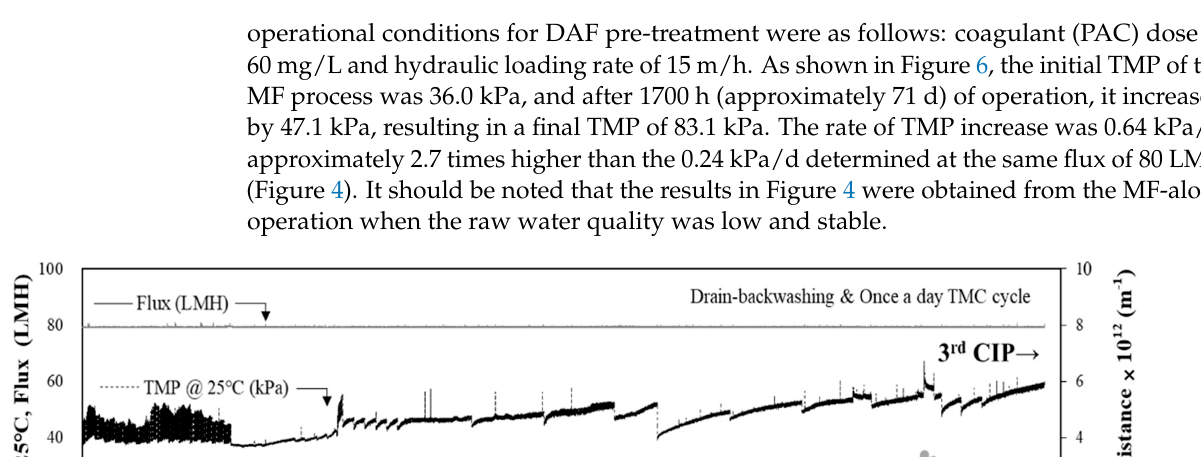
Figure 7. Particle count analysis according to coagulant does and hydraulic loading rate: ( a ) total particle count and ( b ) particle size distribution . 3.4. Performance of DAF-MF Combined Process After Optimising DAF Operating Conditions The MF process in the DAF-MF process was operated for approximately 1400 h (ap- proximately 58 d) at a flux of 80 LMH, and the performance of the MF process is shown